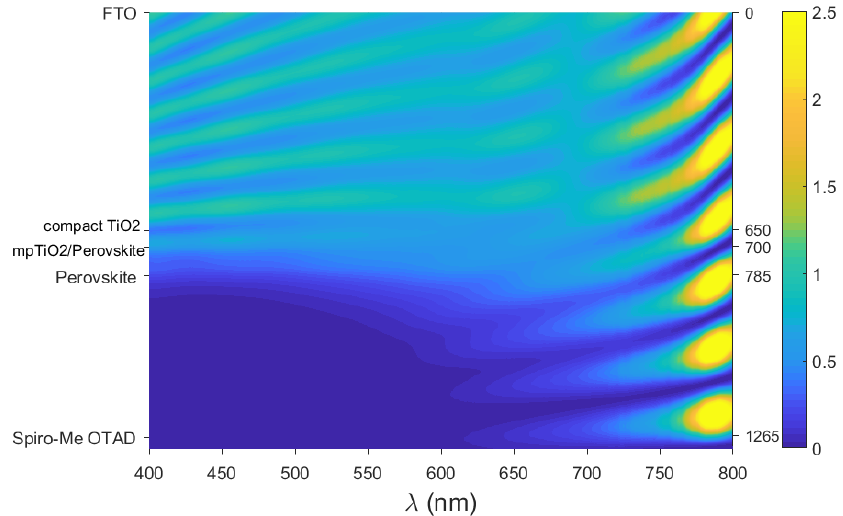
Figure 5. Distribution of the electric field intensity inside the planar structure. The thickness of the perovskite layer was 480 nm.